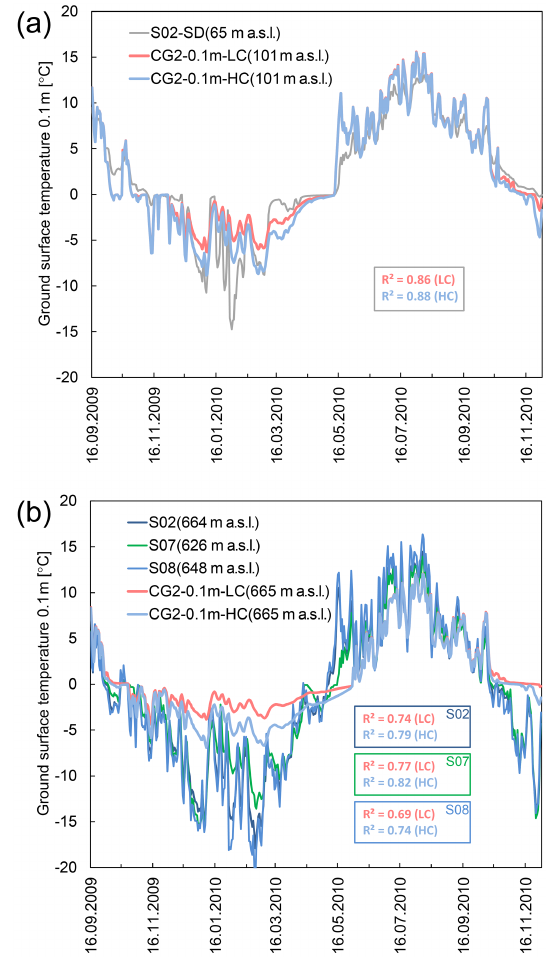
Figure 7. One year of observed soil surface temperatures (SST) at sites with an established soil and snow cover compared with the modelled SST from the transient permafrost model CryoGrid2 (CG2) for high (HC) and low (LC) thermal conductivity of the snow: (a) time series of SST at site S02 – placed next to the air temperature measurement location in the valley floor – compared to the modelled CG2 series for the actual grid cell; (b) SST series for the soil sites close to the release area (S02, S07 and S08) compared to the corresponding grid cell with similar elevation as the release area (i.e.